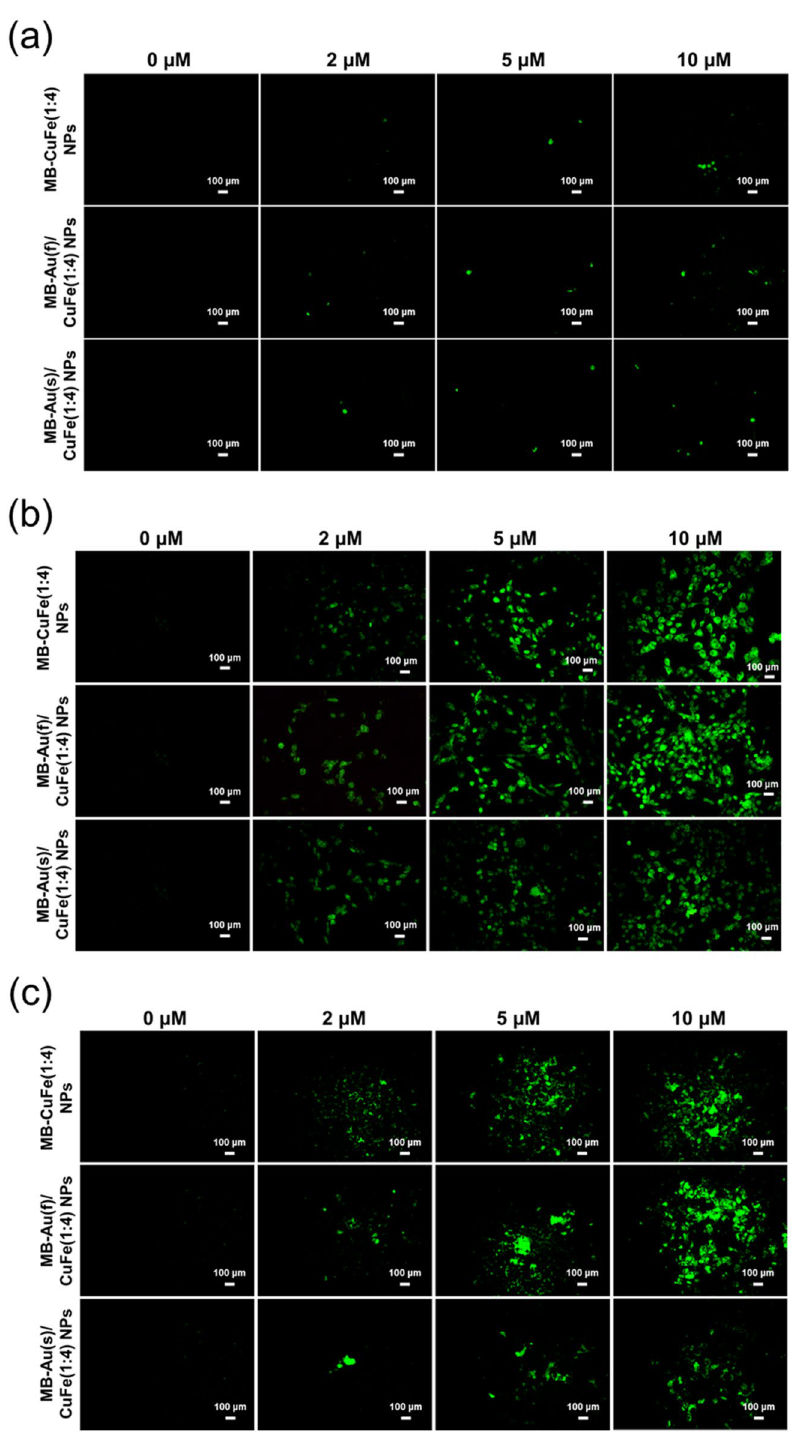
Figure 6. The DCFH-DA performance. ( a ) Without light irradiation. ( b ) With light irradiation after 24 h of incubation. ( c ) With light irradiation after 48 h of